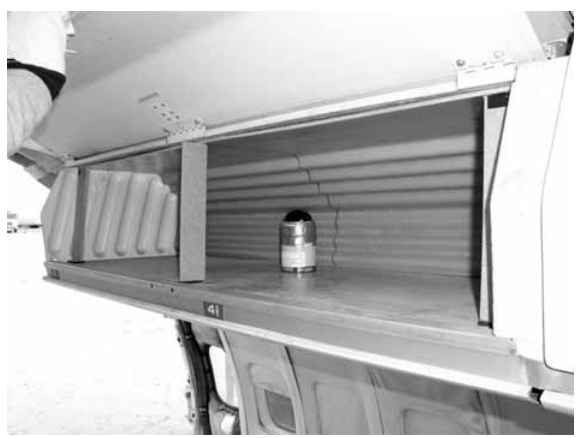
Fig. 15. Inside view of basic shield test